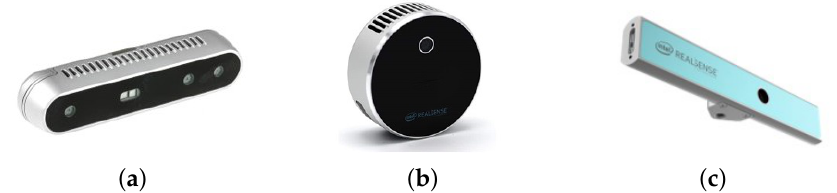
Figure 1. Intel ® RealSense™ cameras considered in this work. ( a ) Intel ® RealSense™ D415. ( b ) Intel ® RealSense™ L515. ( c ) Intel ® RealSense™